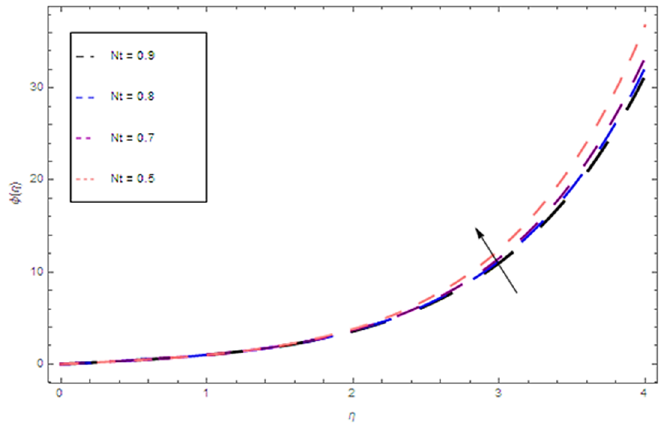
Figure 15. Impact of Nt on   . Figure 15. Impact of Nt on θ ( η ) for M = 0.3, Nb = 0.7, S = 0.5,Pr = 1, Sc = 0.5, Ω = Figure 15. Impact of Nt on Figure 15. Impact of Nt on